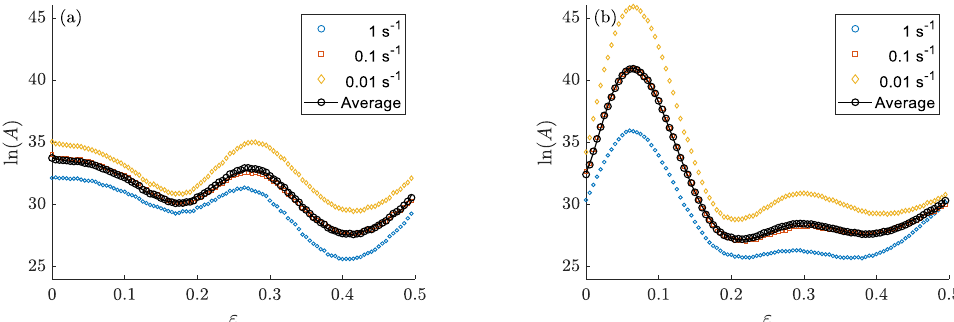
Figure 7. The estimated values of ln ( A ) as functions of strain and strain rate, for α and n treated as ( a ) functions of strain, and ( b )